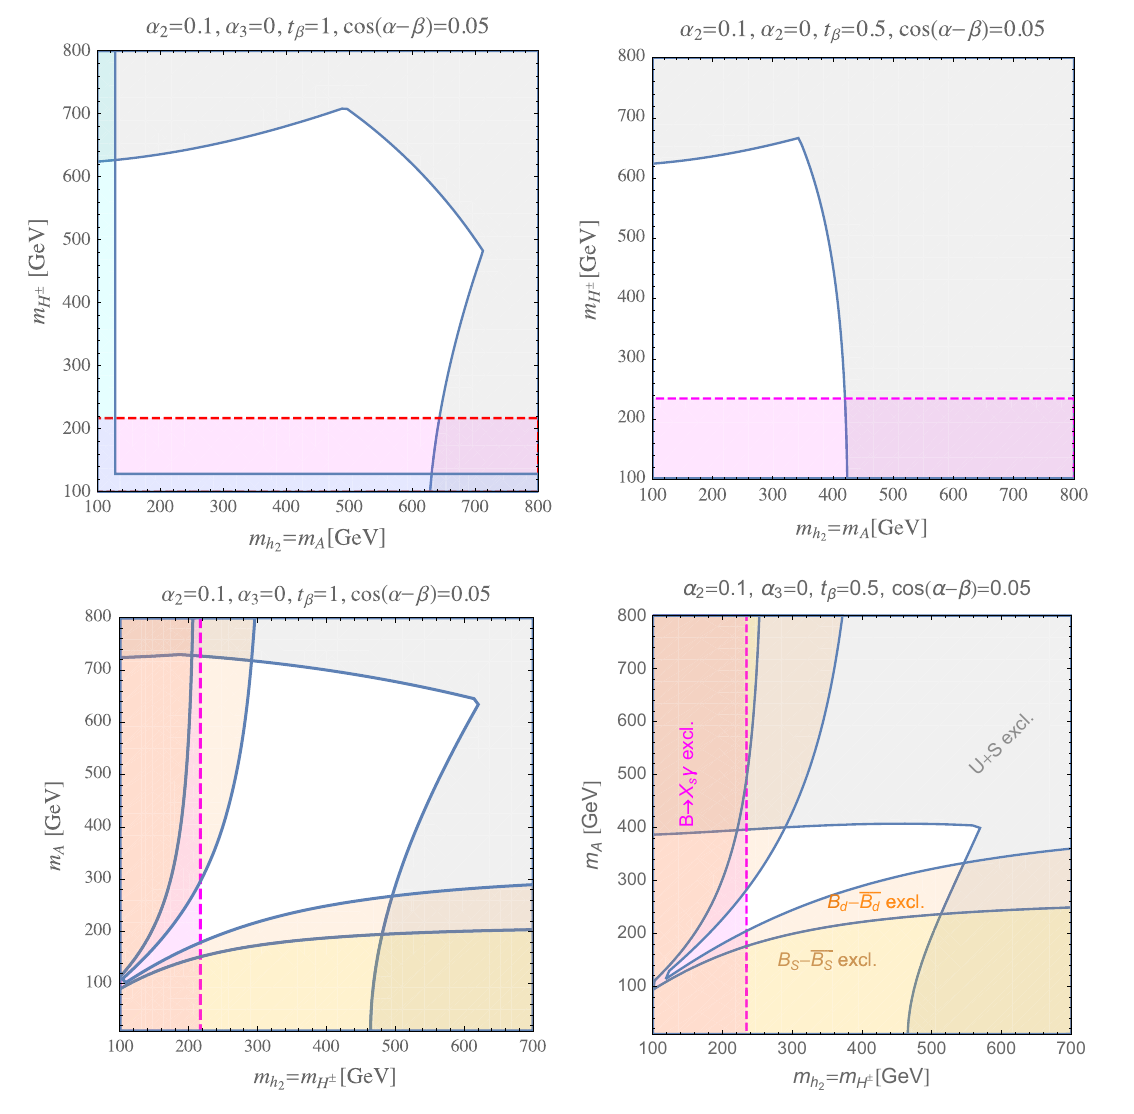
Fig. 4 Parameter space in terms of m h and m H ± (upper frames), and zero. The gray regions are excluded by unitarity and stability bounds. 2 m A (lower frames). tan β = 1 in the left and 0.5 in the right panels. We The magenta regions are excluded by B → X s γ , and cyan region is = 1 TeV, cos (α − β) = 0 . 05, and y u = y SM have chosen v s = 2 m h excluded by B s → μ + μ − . The yellow and orange regions are excluded t 33 3 by B s and B d mixings, in all frames. The mixing between heavy CP -even scalars is taken to be